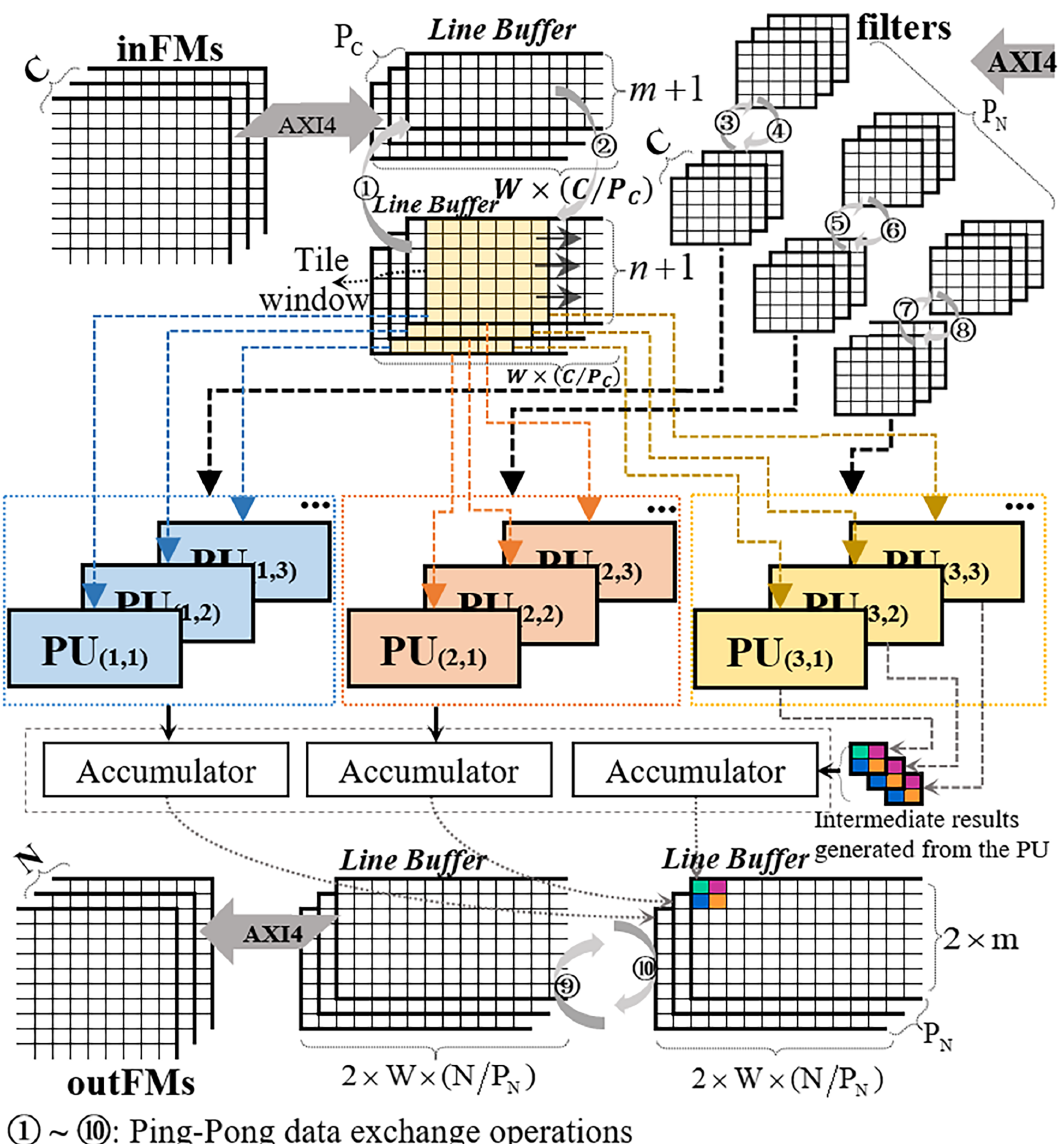
Figure 8. An illustration of the Wino-transCONV design